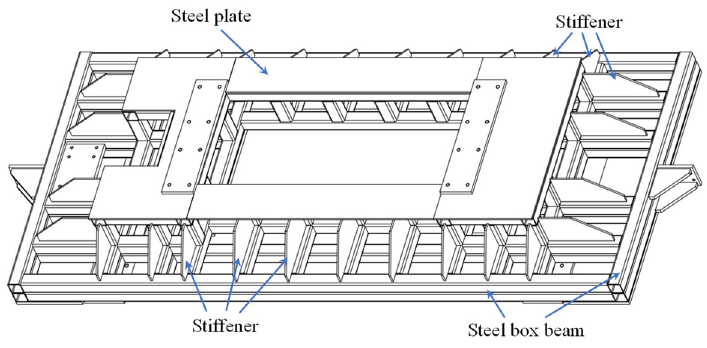
Figure 5. Schematic of the supporting frame.